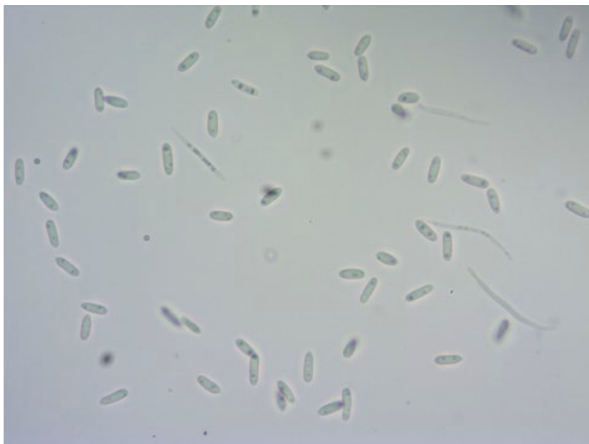
Figure 4. Alpha (α; 8 - 12 μm × 2-3 μm) and beta (β; 18- 30 μm × 1.0-1.5 μm) conidia of Diaporthe spp., produced in PDA